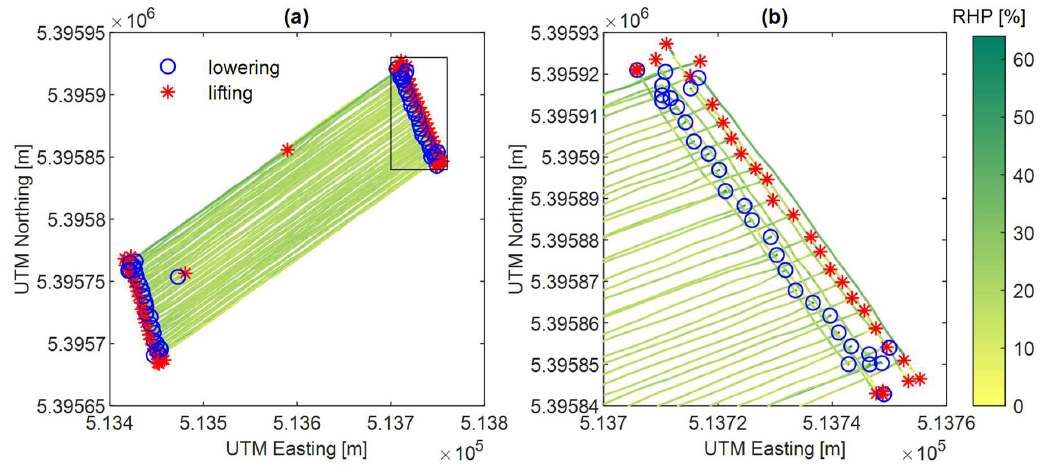
Figure 11. ( a ) D-GNSS positions of the lowering, lifting and in-work points with deposited RHP values; and ( b ) a zoomed area.